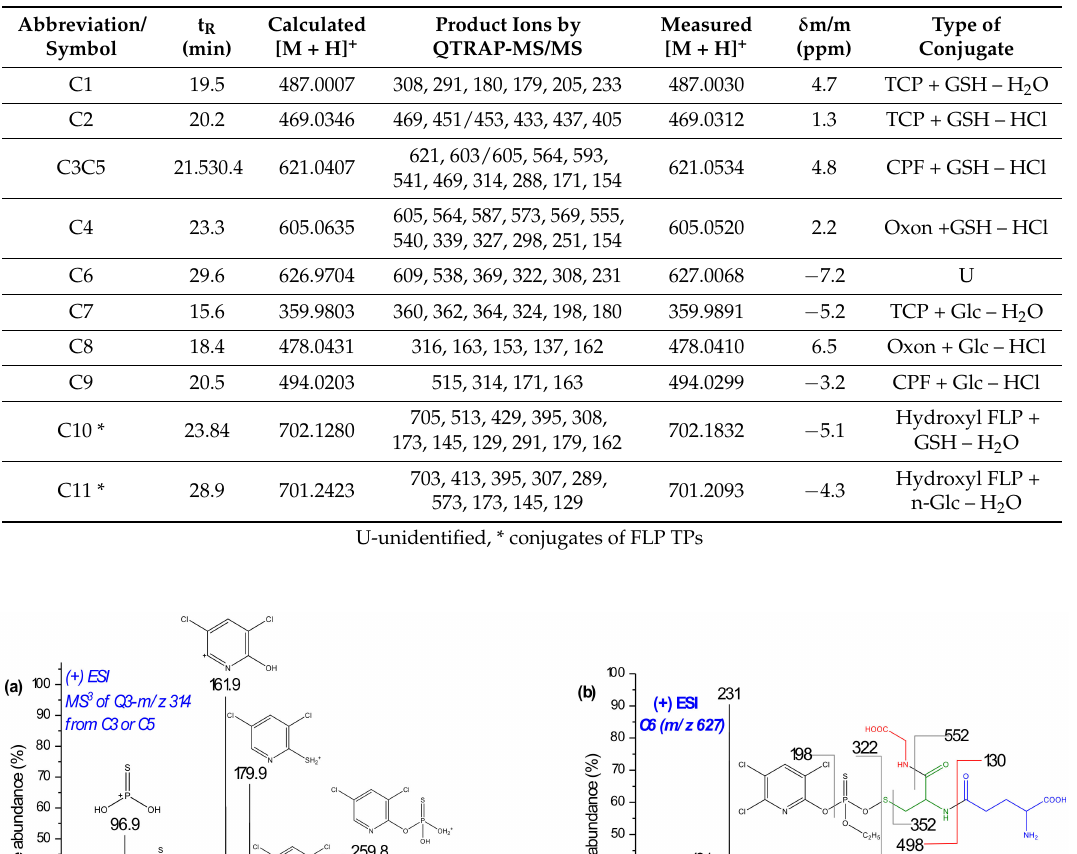
Table 1. Retention time (t R ) and MS/MS product ions measured by LC-MS/MS and δ m/m measured by TripleTOF of GSH and glucoside (Glc) adducts of CPF and FLP oxidative products using BDD as WE.